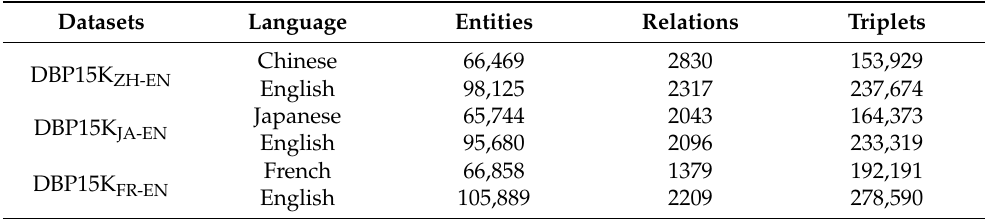
Table 2. The statistics of